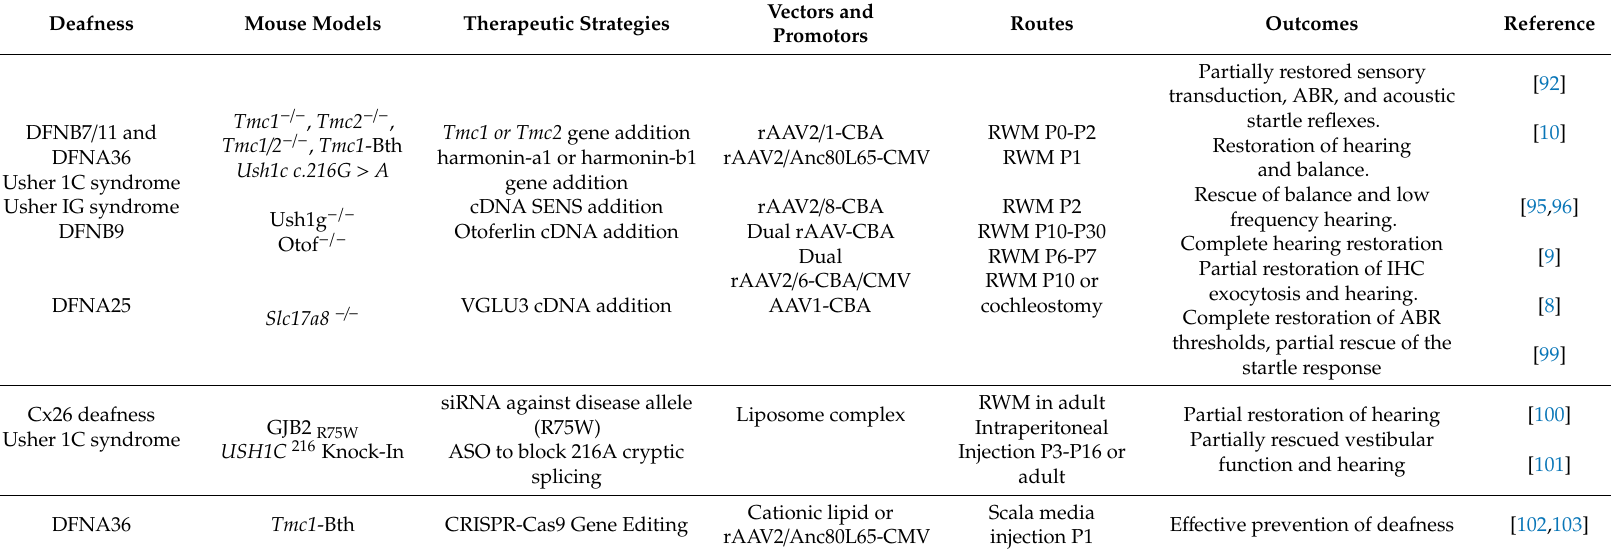
Table 1. Cochlear gene therapies . Summarizing of the recent proof-of-principle studies demonstrating the therapeutic potential of gene therapies for preventing or treating inner ear genetic diseases. ABR: auditory brainstem response. RWM: round-window membrane. IHC: inner hair cell. ASO: antisense oligonucleotides. CBA: chicken β -actin promotor. CMV: cytomegalovirus